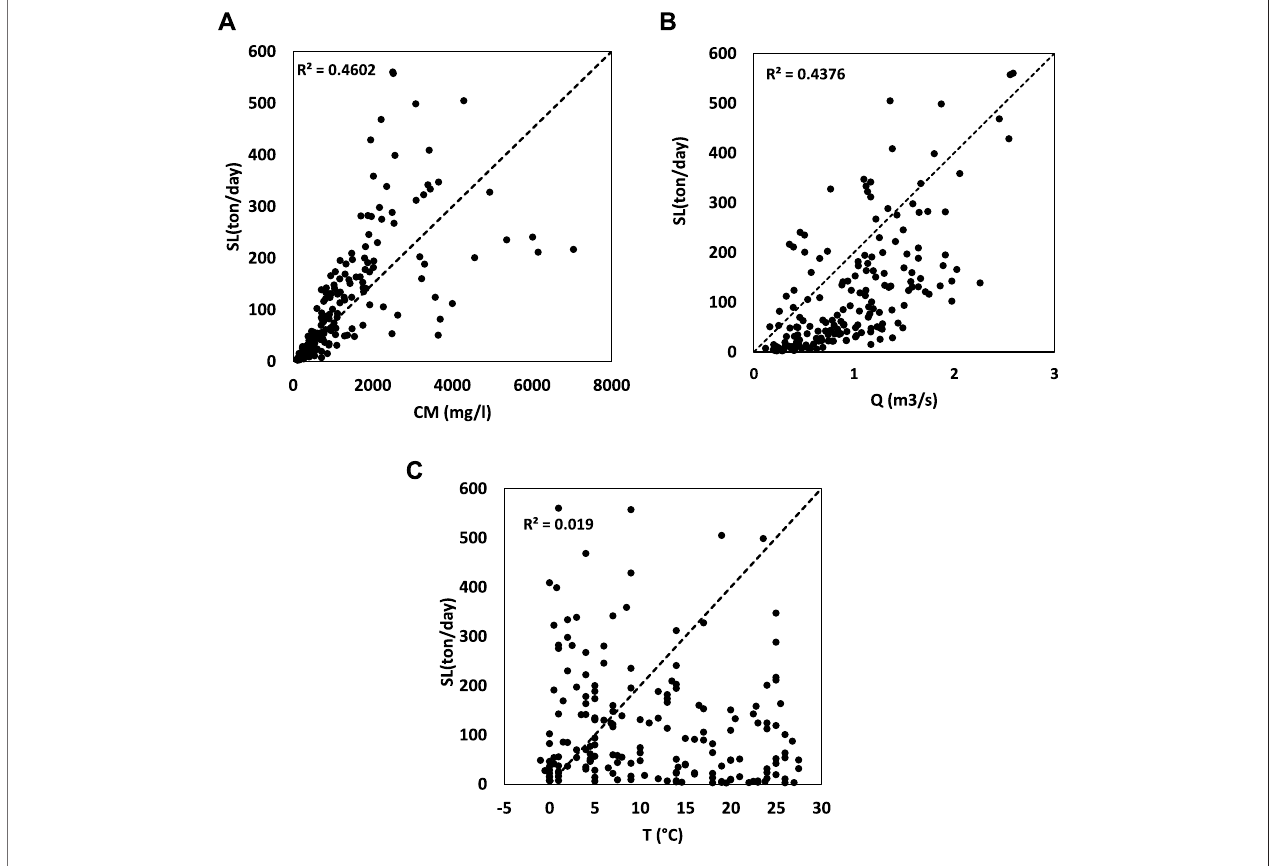
FIGURE 3 | R 2 of input data with the amount of SL recorded: (A) CM, (B) Q, (C) T.